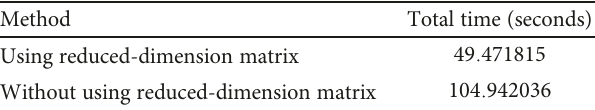
Table 2: Elapsed time of the two methods (100-simulation time, AMD E-450 APU 2 ∗ 1.65 GHz, Windows 7 pro 64 bit, 2 GB